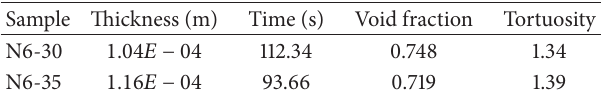
Table 1: The void volume fraction of the nylon-6 nanofibrous struc- tures.